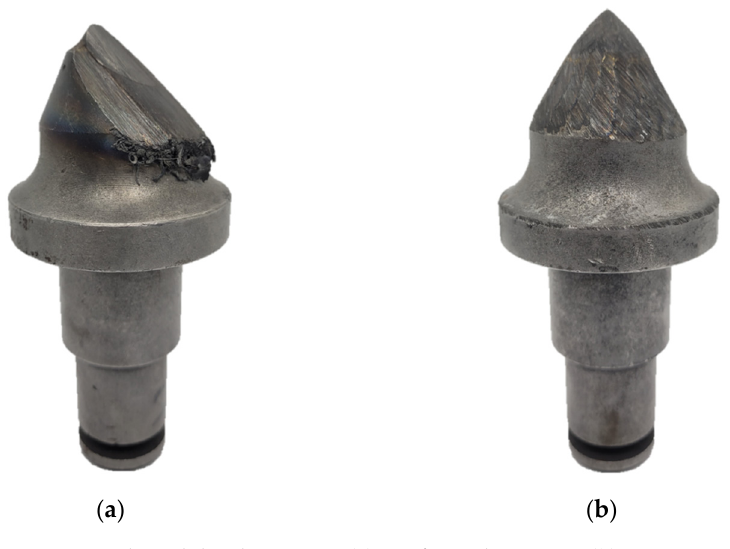
Figure 1. Tools with local cavities—( a ); uniform abrasions—( b ).